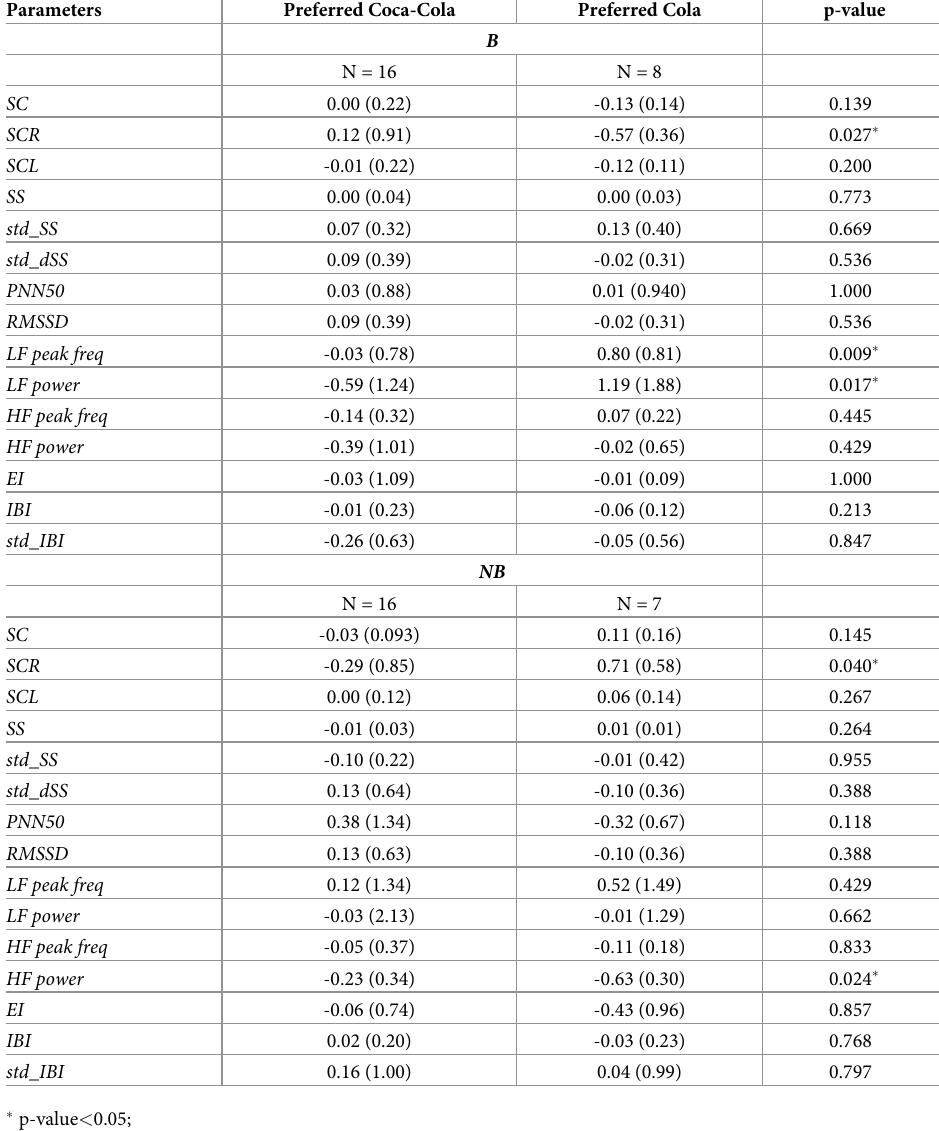
Table 3. Comparison between Coca-Cola and Cola when preferred.